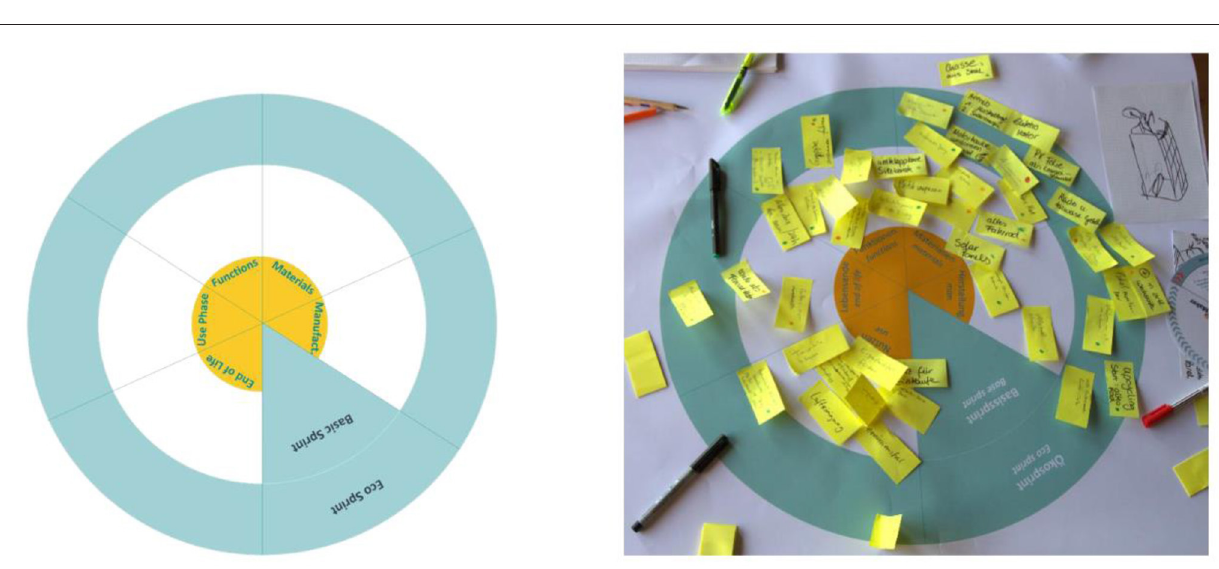
FIGURE 7 | ecoMaker design sprint